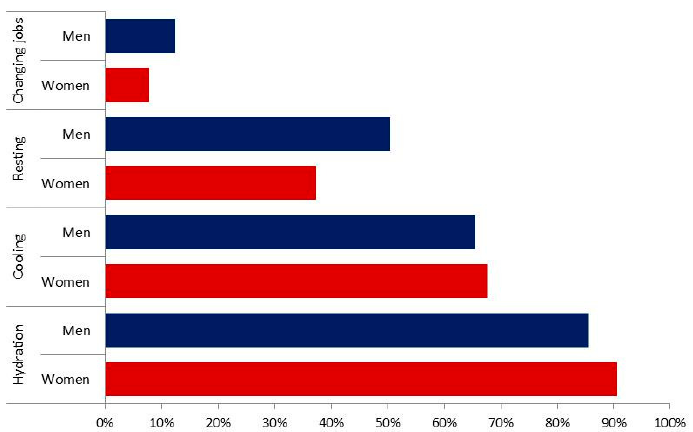
Figure 1. Percentage of heat stressed respondents (N = 1285) adopting specific heat relief measures—by gender. Table 5. Results of separate logit models for each heat stress relief/adaptation measure, model coefficients (Coeff), odds ratio (OR), and 95% confidence interval (lower and upper limit).